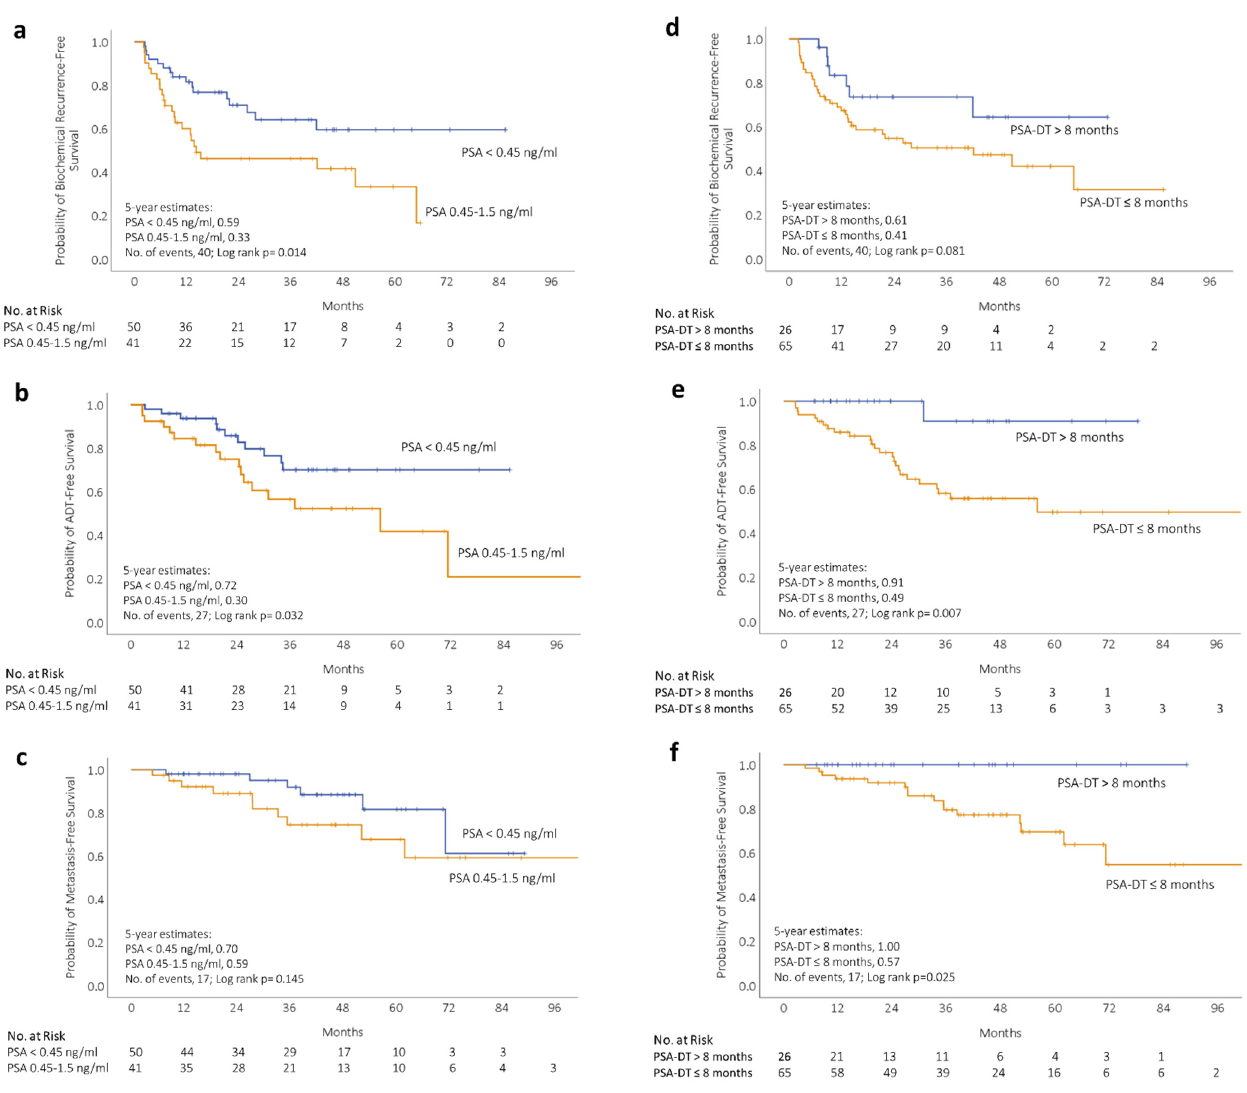
Figure 1. Kaplan–Meier survival curves depicting ( a ) biochemical recurrence-free, ( b ) ADT-free, and ( c ) metastasis-free survival after SRT in 91 patients stratified by pre-SRT PSA level into PSA < 0.45 ng/mL (blue) and PSA 0.45–1.5 ng/mL (orange). Kaplan–Meier survival curves depicting ( d ) biochemical recurrence-free, ( e ) ADT-free, and ( f ) metastasis-free survival after SRT in 91 patients stratified by PSA doubling time (PSA-DT) into PSA-DT > 8 months (blue) and PSA-DT ≤ 8 months (orange).